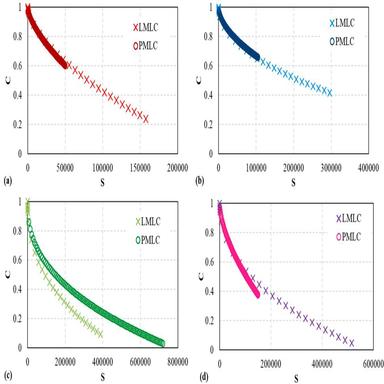
C vs S curves of mixtures under LMLC and PMLC conditions: (a) CONV; (b) TLAF; (c) HIMA; (d) SBS.